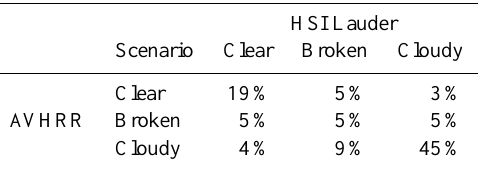
Figure 9. Histogram of instantaneous CFC differences between AVHRR and HSI in Lauder, New Zealand, from 1 November to 31 December 2009. The occurrences are normalized with their ac- cording total count. Negative differences express an underestima- tion of the CFC by AVHRR compared to HSI; positive differences express an overestimation. Table 7. AVHRR in Lauder, New Zealand: contingency table com- paring HSI and AVHRR CFC for the cases of cloud-free (0–2 ok- tas), broken clouds (3–5 oktas) and cloud-covered (6–8 oktas). Val- ues represent ratio between match-ups and total of 442 valid mea-